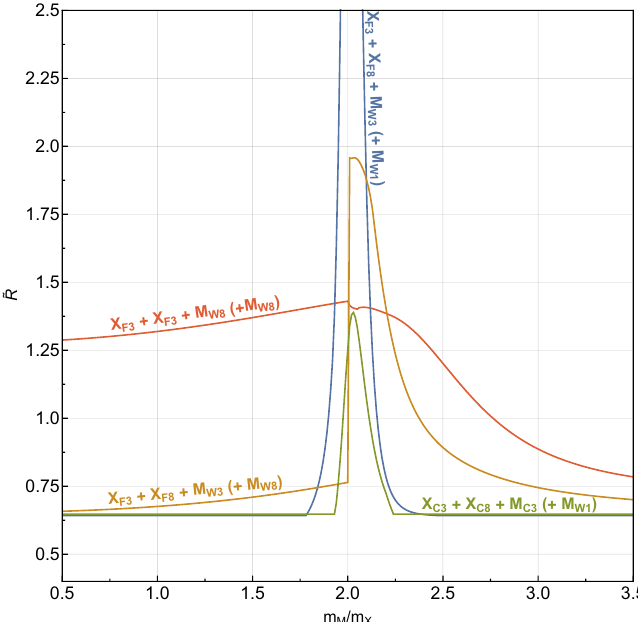
m M as a function of 4